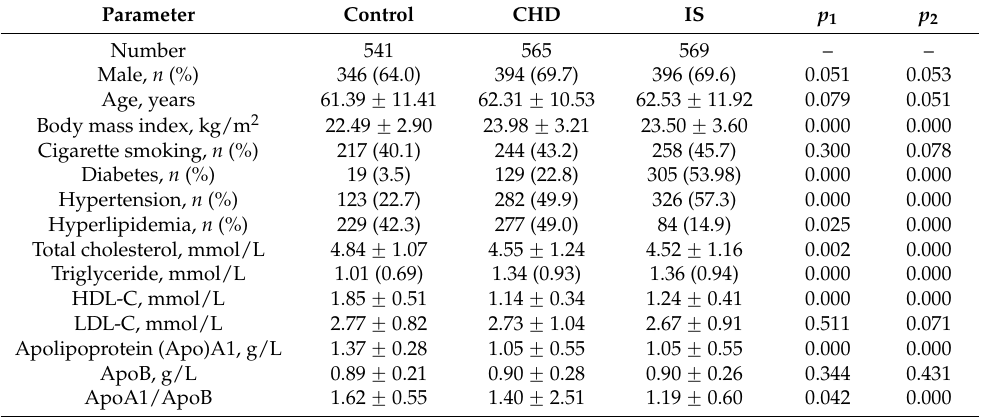
Table 1. Comparison of the clinical characteristics and serum lipid levels between controls and